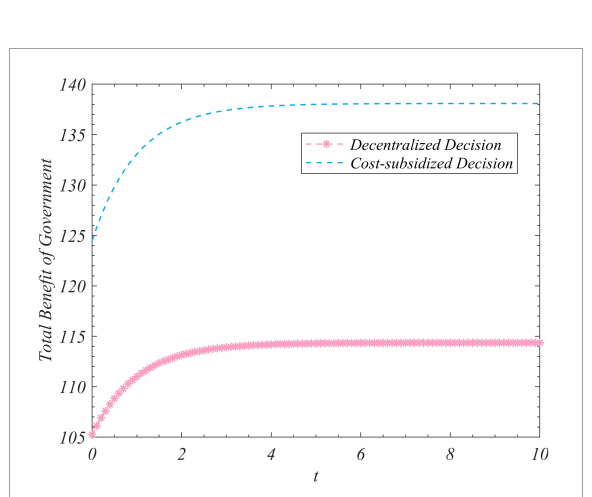
FIGURE2 The trends of the gross revenue of the government under the decentralized and subsidized decision-making